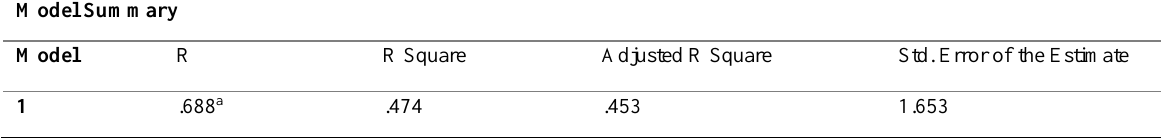
Table 14: Coefficient of Determination Test Results